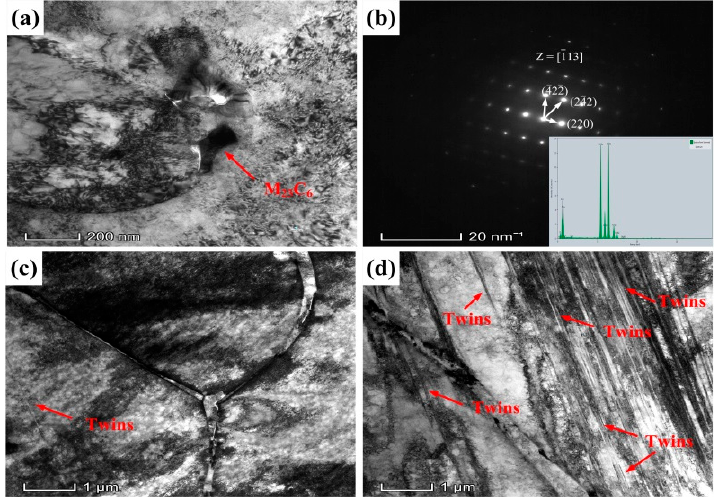
Figure 17. TEM micrographs of the tensile samples of the welded joints: ( a – c ) 1670-8, ( d ) 1670-14.